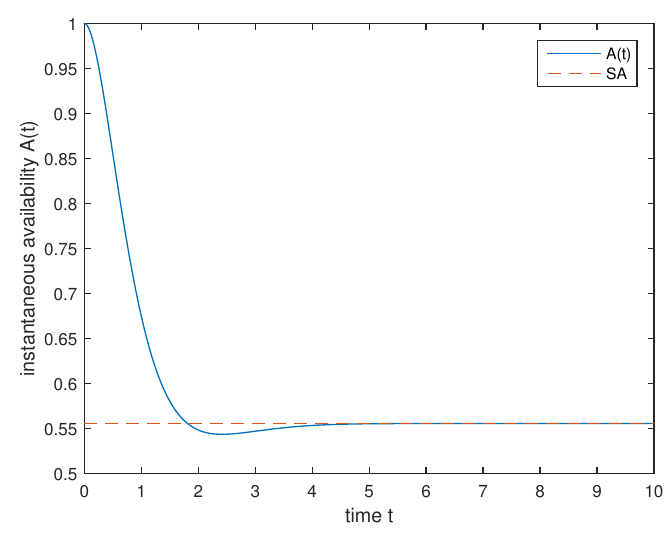
Figure 5. The curve of IA for case 3.